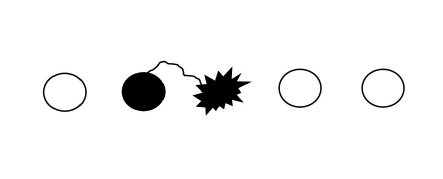
Figure 1: At each step of plasmodium propagation, there are only two attractants which can be occu- pied. At the first time step the plasmodium expan- sion is coded by the 3-adic integer . . . 000001.